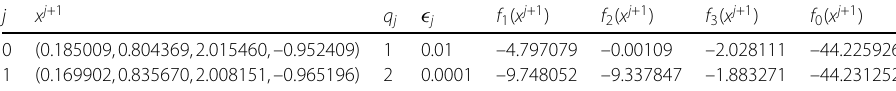
Table 1 Numerical results for Example 4.1 with x 0 = (0,0,0,0)